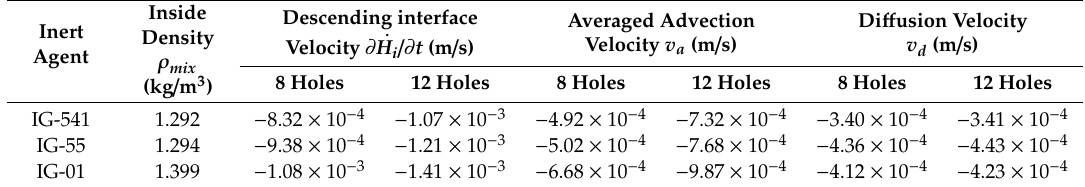
Table 6. Comparison of the z-direction advection velocity v a and the z-direction di ff usion velocity v d for each inert